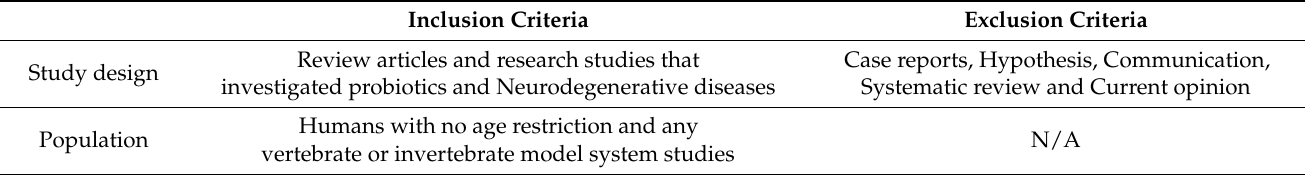
Table 1. Inclusion and exclusion